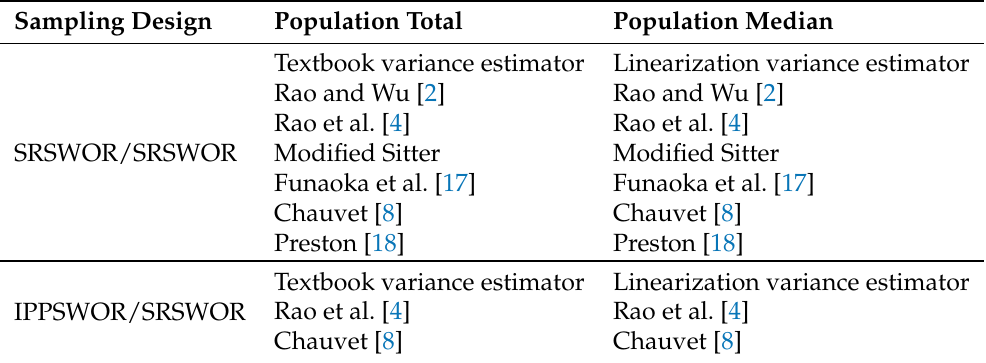
Table 1. Variance estimation procedures for each population parameter/sampling